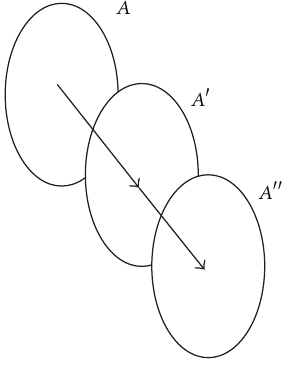
Figure 3: Example of blob prediction from the matched blob in the previous two